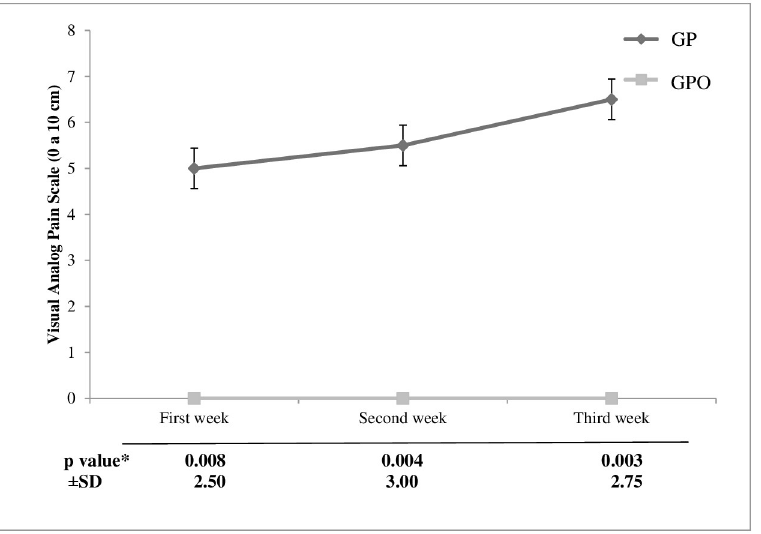
Fig 2. Means (standard deviation) of reported sensitivity level data using the visual analog scale. � Calculated by the Mann-Whitney test.